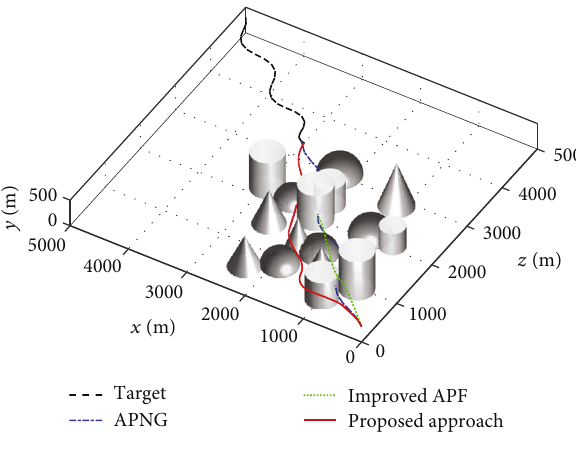
Figure 23: Flight trajectories of interceptor and target in case